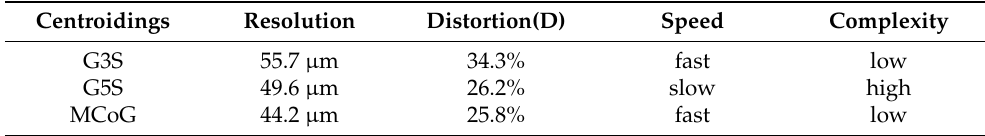
Table 4. Performance comparison of different centroiding algorithms.